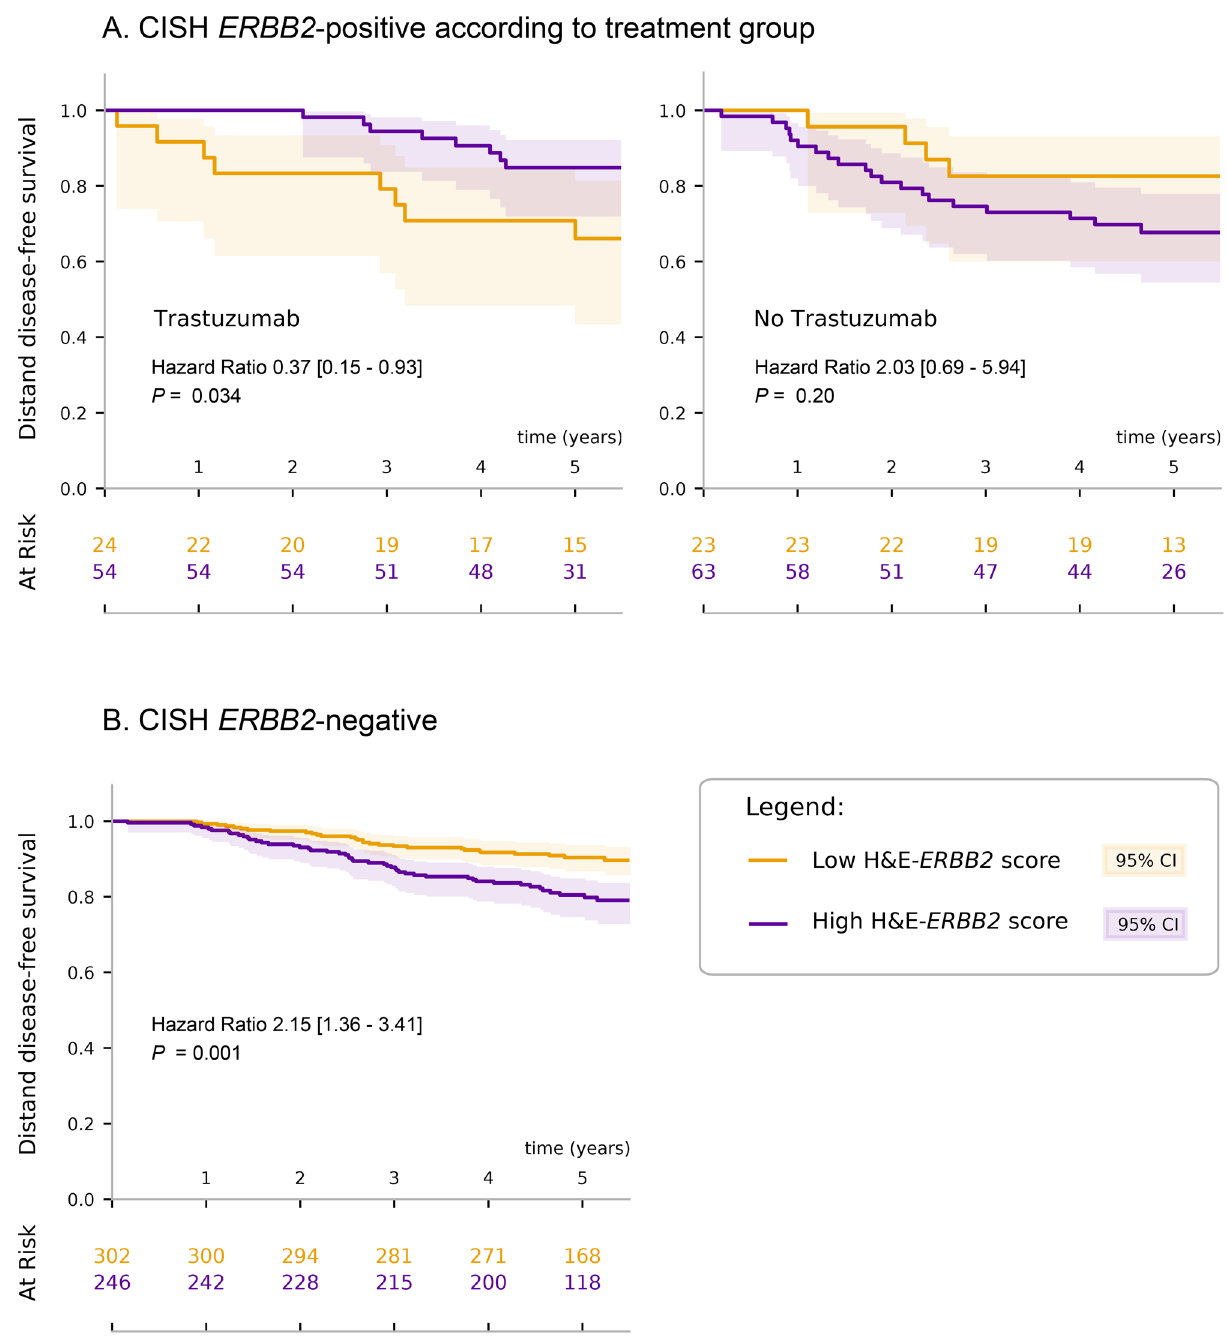
Figure 3. Cancer tissue morphology-based H&E- ERBB2 score and distant disease-free survival. ( A ) Evaluation of H&E- ERBB2 scores and distant disease-free survival (DDFS) in patients with ERBB2 -positive breast cancer as determined by chromogenic in situ hybridization (CISH) in the FinHer trial series. Left panel: Patients treated after breast surgery with chemotherapy plus adjuvant trastuzumab. Right panel: Patients treated with chemotherapy but without trastuzumab. ( B ) The DDFS of CISH ERBB2 -negative patients in the FinHer series stratified by the H&E- ERBB2 score. None of the patients judged ERBB2 -negative by CISH received adjuvant